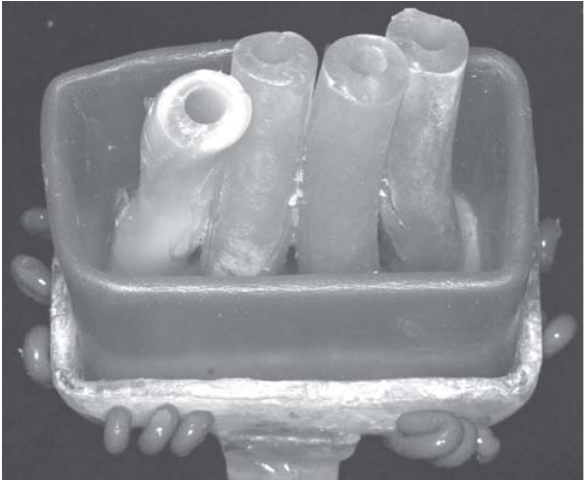
FIGURE 1- Mold with the 7 wax dyke and after relief with rubber